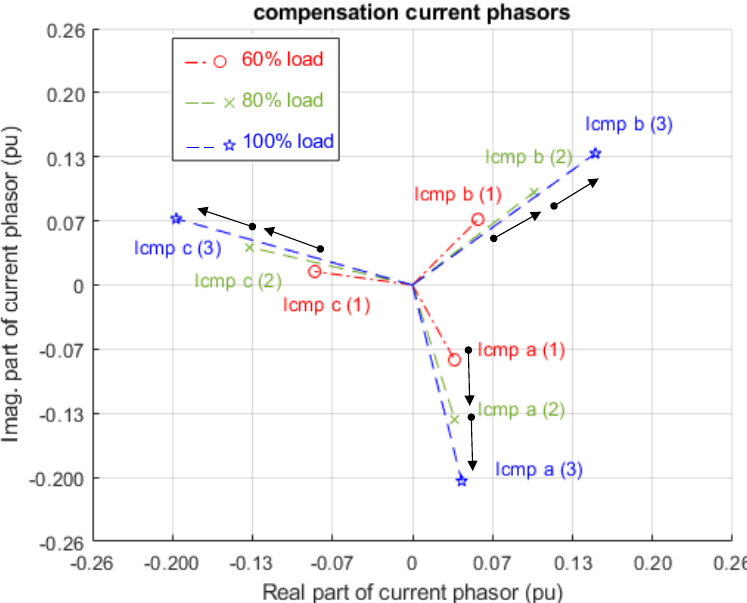
Figure 9. The compensation current phasors relating to increasing inductive load (the current base was 757.6 A).